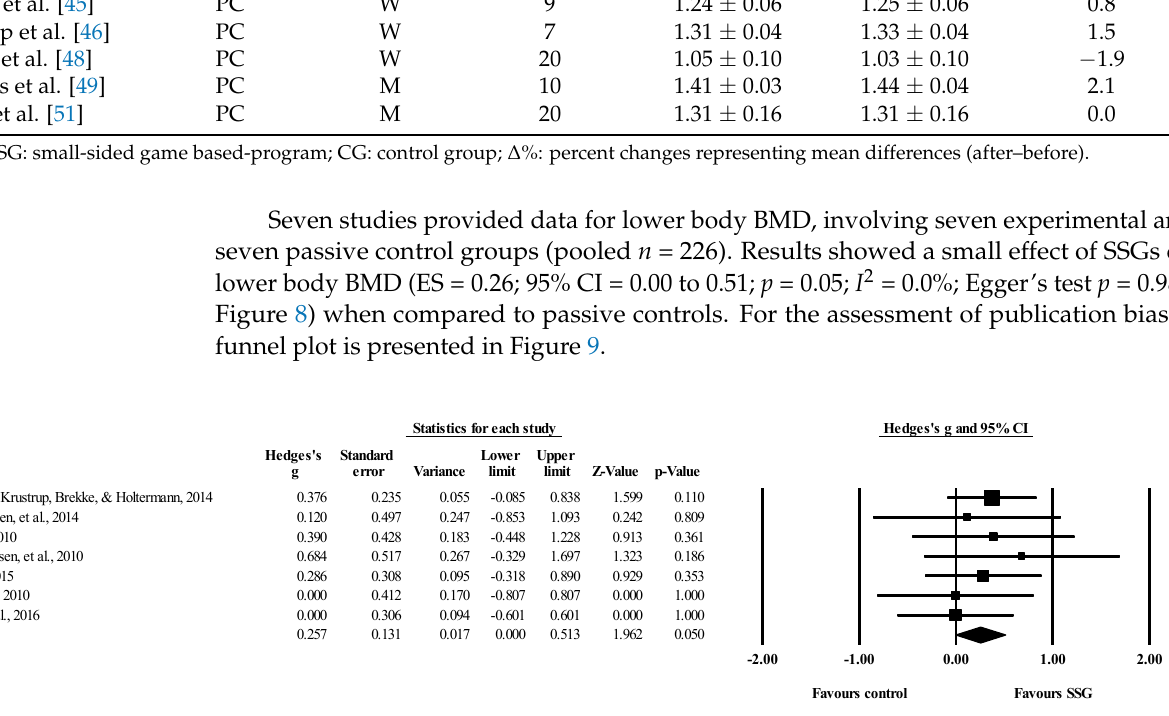
Figure 8. Forest plot of changes in lower-body bone mineral density in untrained adults after a training program based on soccer small-sided games (SSG) compared to controls. Values shown are effect sizes (Hedges’s g) with 95% confidence intervals (CI). The size of the plotted squares reflects the statistical weight of each study. The black diamond reflects the overall result.